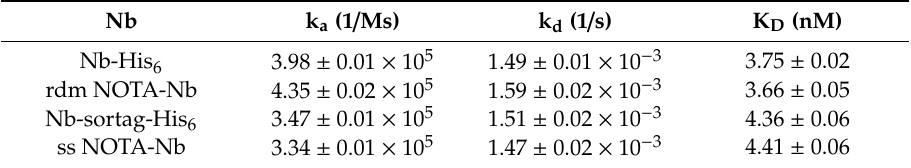
Table 1. A ffi nity kinetics measurements by SPR. Equilibrium dissociation constant (K D ), association constant (k a ) and dissociation constant (k d ) of the di ff erent Nb variants binding to immobilized recombinant hPD-L1 as determined by SPR: the hPD-L1 Nb containing both the sortag and hexahistidine tags (Nb-sortag-His 6 ), the site-specifically coupled NOTA-(hPD-L1) Nb (ss NOTA-Nb), the unmodified hPD-L1 Nb with a histag (Nb-His 6 ) and the randomly coupled NOTA-(hPD-L1) Nb (rdm NOTA-Nb). Nb k a (1 / Ms)